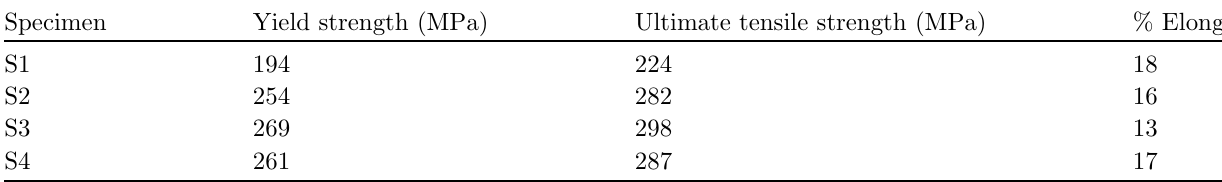
Table 6. Results of tensile test.